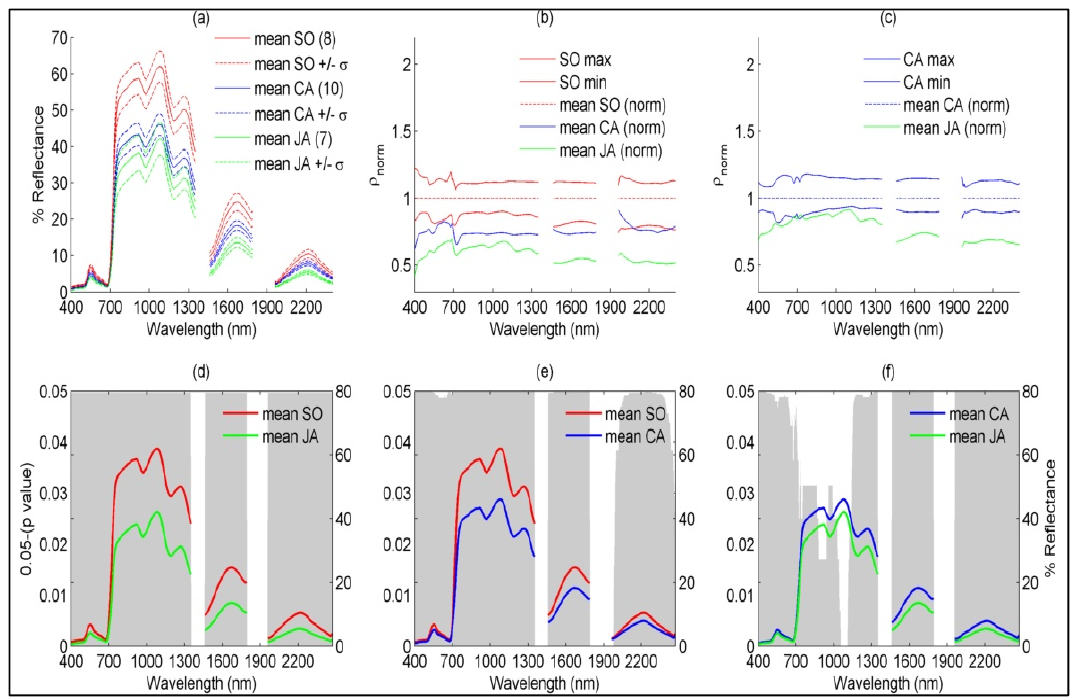
Figure 4. ( a ) Average spectra (along with standard deviation) measured in nadir direction above canopy of SO , CA and JA on 12 and 13 June 2014; ( b ) Shape filter space of SO class with mean of normalized spectra (with respect to SO ) of CA and JA ; ( c ) Shape filter space of CA class with mean of normalized (with respect to CA ) spectra of JA ; ( d – f ) Results of wavelength wise Mann–Whitney U test between spectra sampled at SO , CA and JA locations spectra. Significant differences are denoted with grey shading ( p -value < 0.05). Number of sampling locations is given in brackets in the legend of ( a ). The dissimilarity matrix D was 12.21 between SO and JA, and 8.63 between SO and CA , which indicates a high dissimilarity between the mean spectrum of SO and those of CA and JA . The